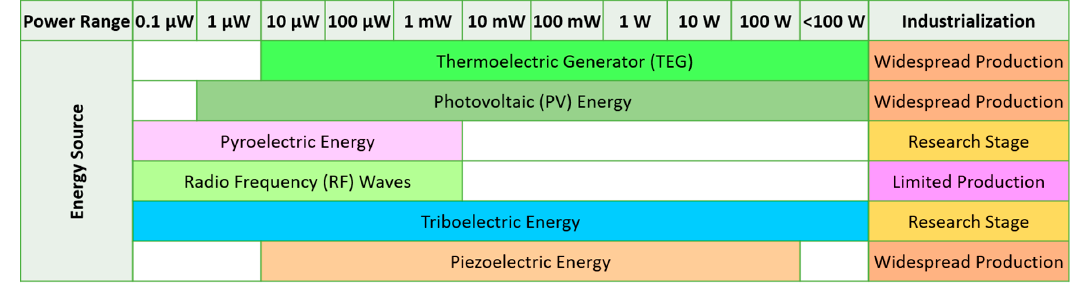
Figure 4. Intermittent amount of power that is generated from common ambient energy sources [90].